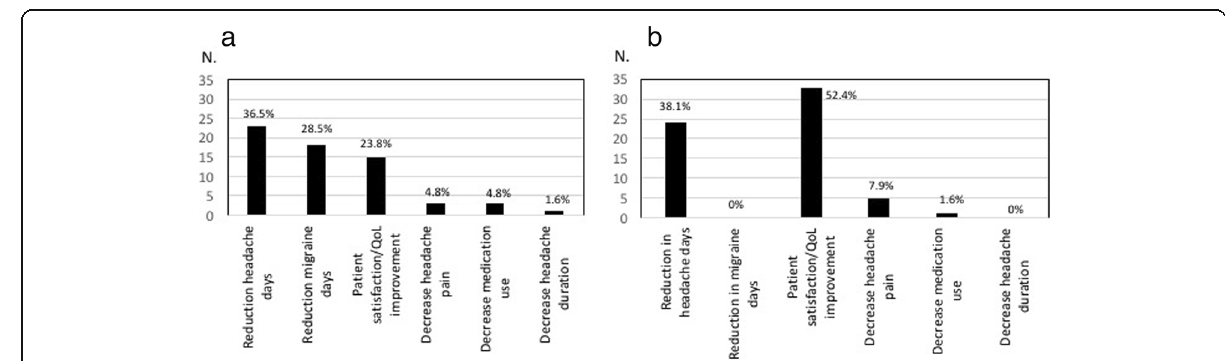
Fig. 3 Most important indicator of treatment efficacy ( a ) for clinicians and ( b ) for patients (as assessed by